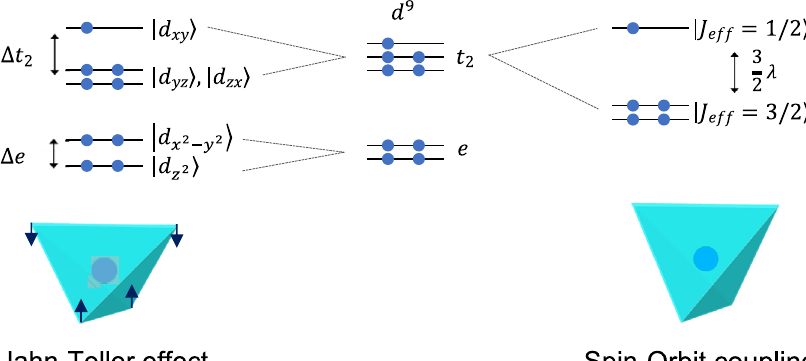
Fig. 1 Schematic illustration on the t 2 splitting of tetrahedral Cu 2 + due to the Jahn-Teller effect (left) and spin-orbit coupling (right).